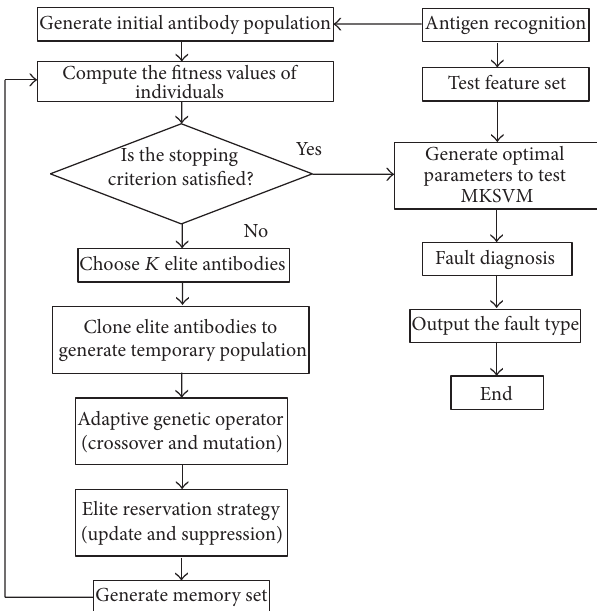
Figure 2: Flowchart of IGA.